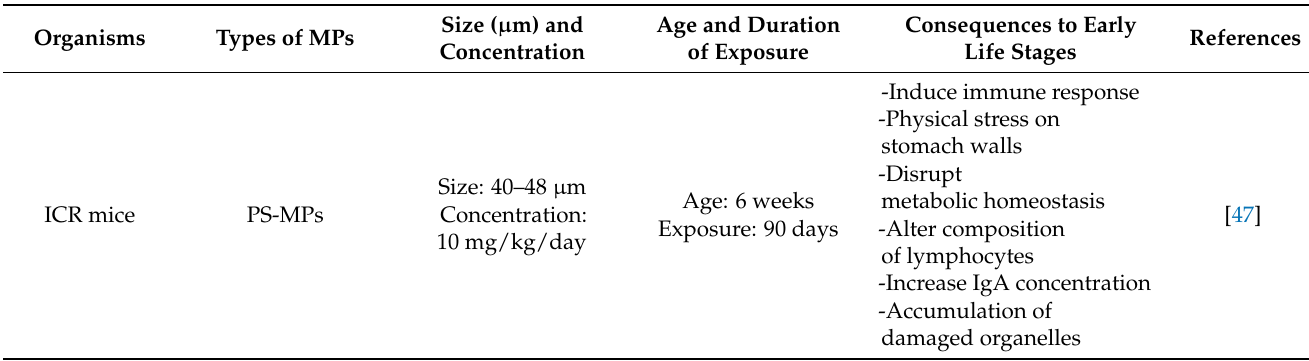
Table 4. Summary of the effects of MPs exposure on the immune system during the early develop- mental